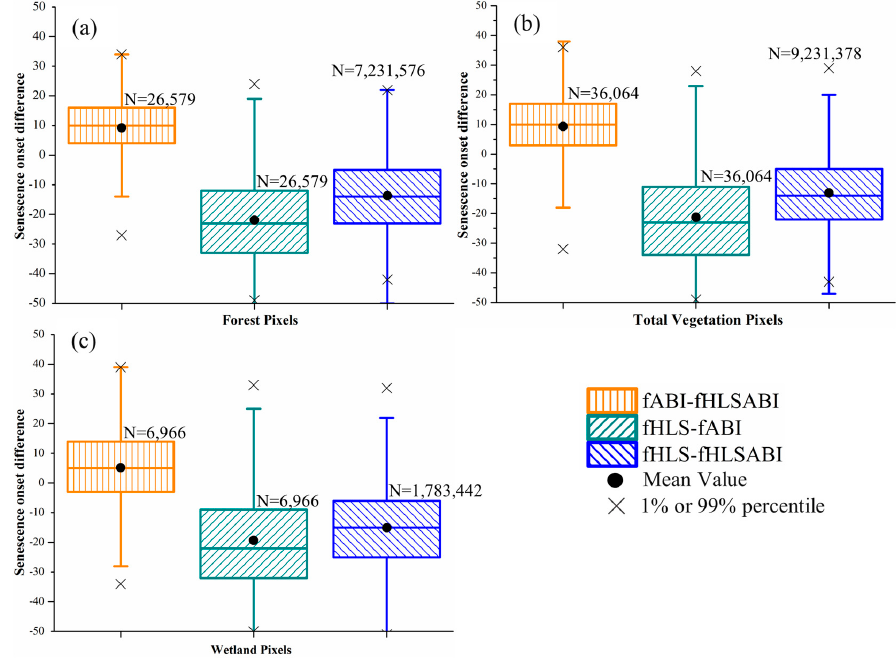
series were larger than those in greenup onset (Figures 7 and 8).